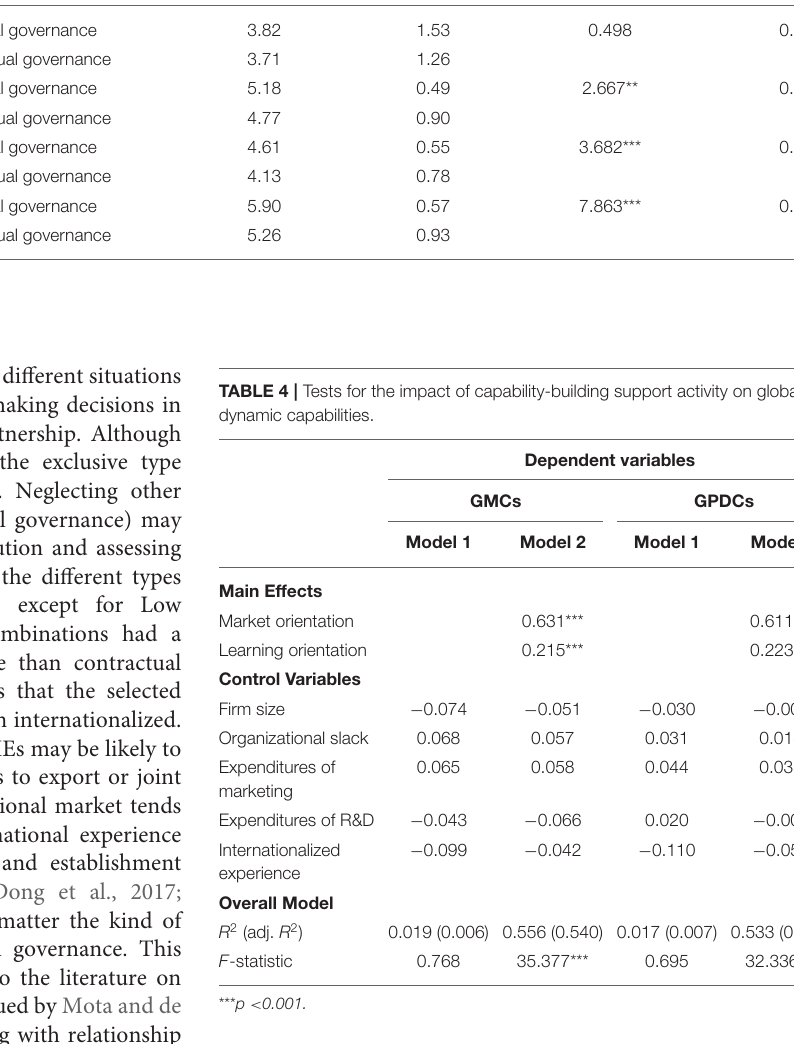
TABLE 3 | Paired sample t -test of relational and contractual governance. Category